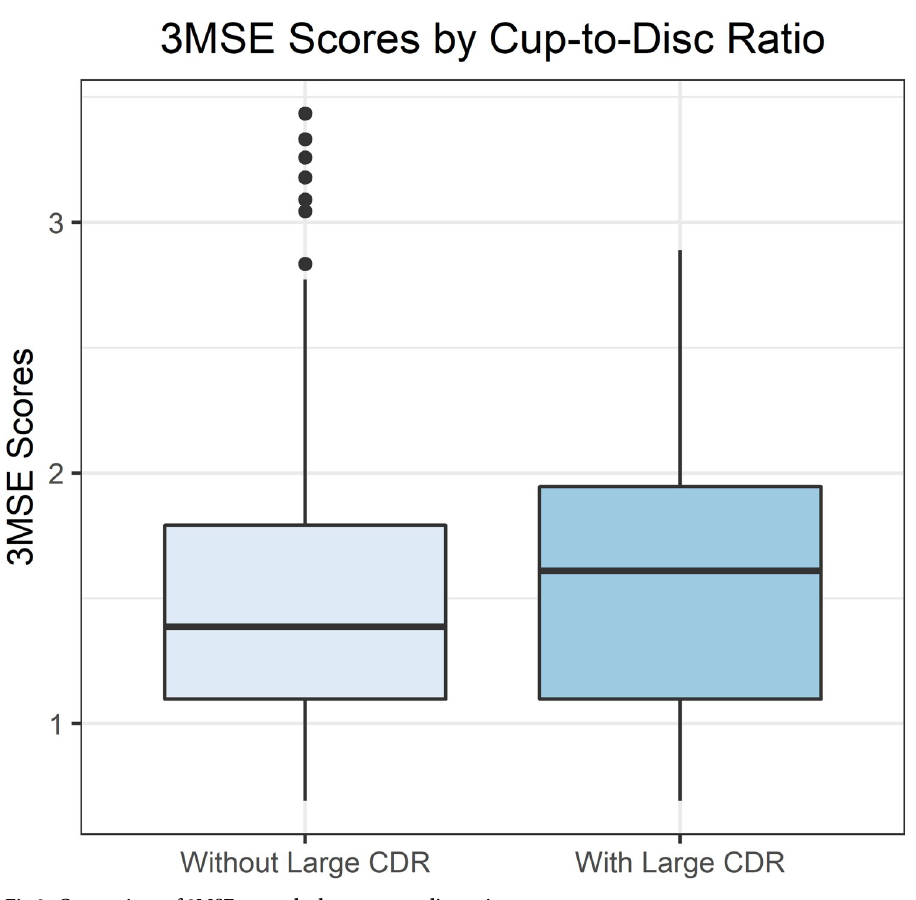
Fig 3. Comparison of 3MSE scores by large cup-to-disc ratio.